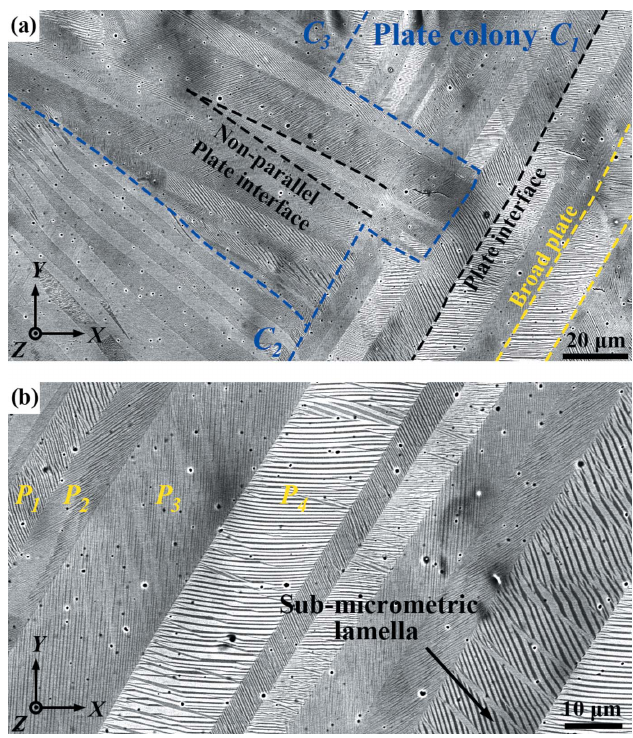
Figure 1 ( a ) A typical backscattered electron (BSE) image of Ni 50 Mn 38 Sb 12 intragranular martensite. ( b ) A magnified BSE image of the plate colony C 1 in panel ( a ).